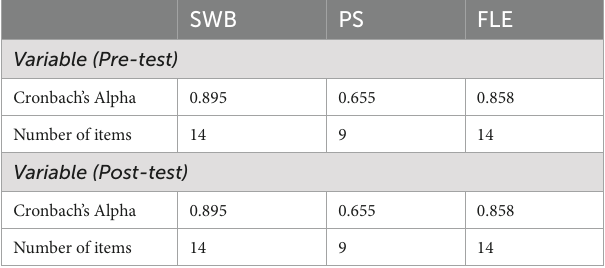
TABLE 1 Reliability statistics for the variables (Cronbach’s